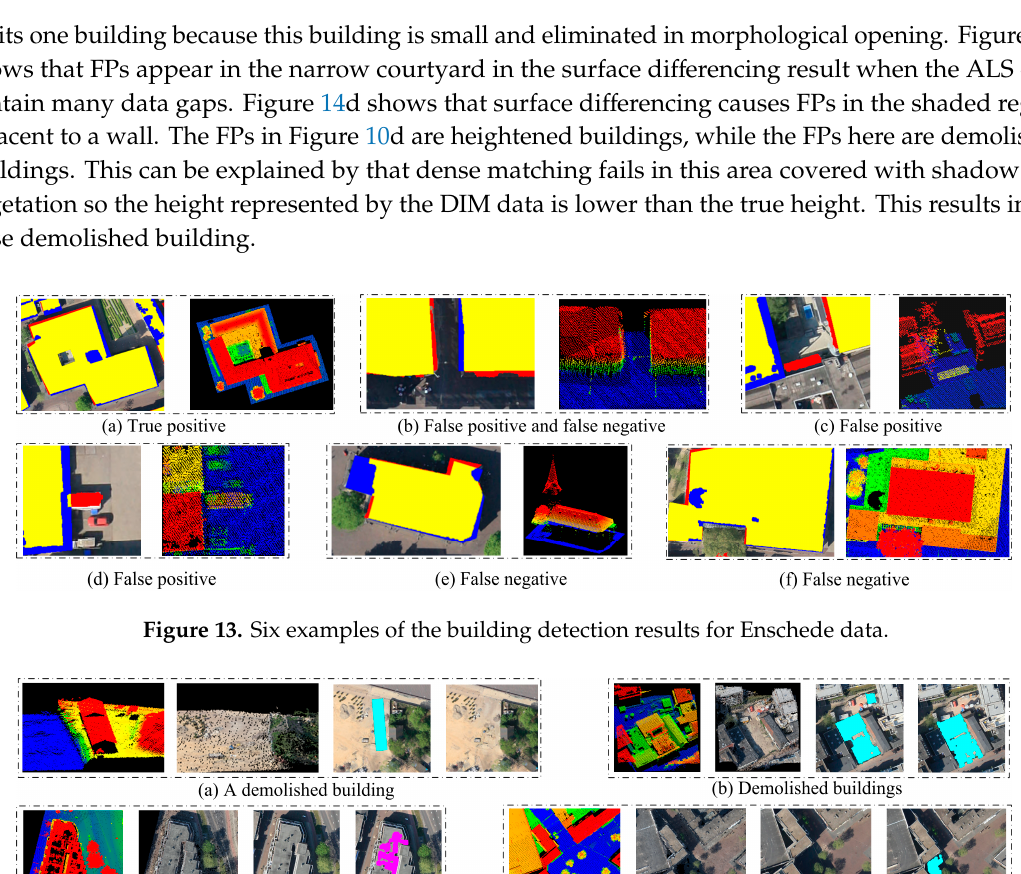
Figure 14. Four examples of the change detection results for Enschede data.